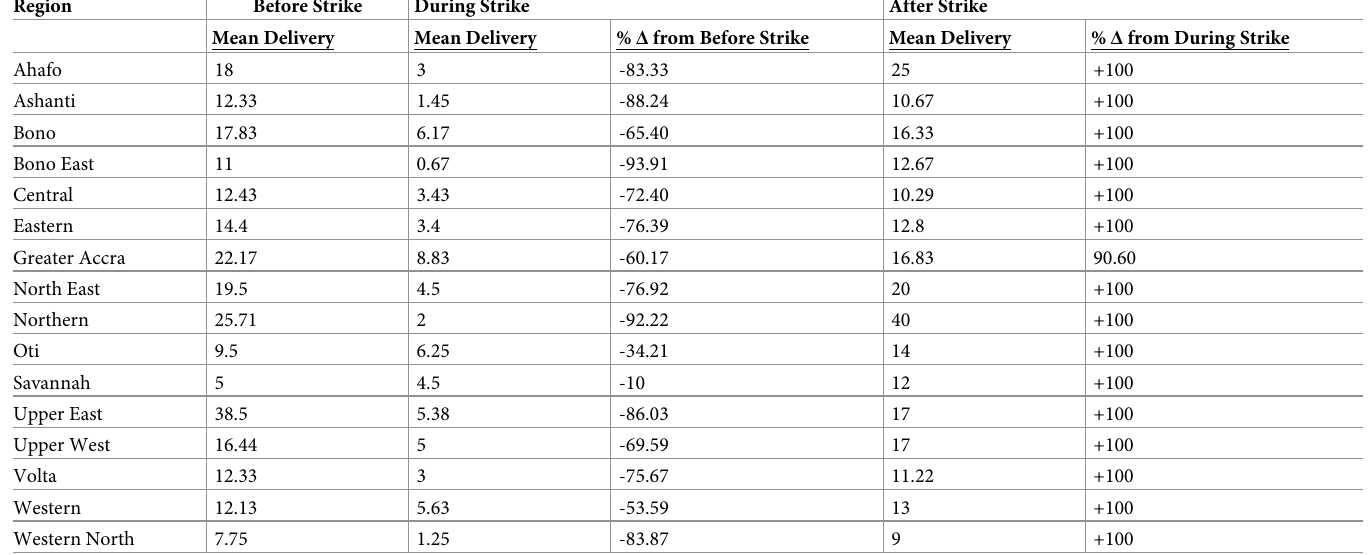
Table 4. Percentage change in the mean deliveries conducted during and after strike. Region Before Strike During